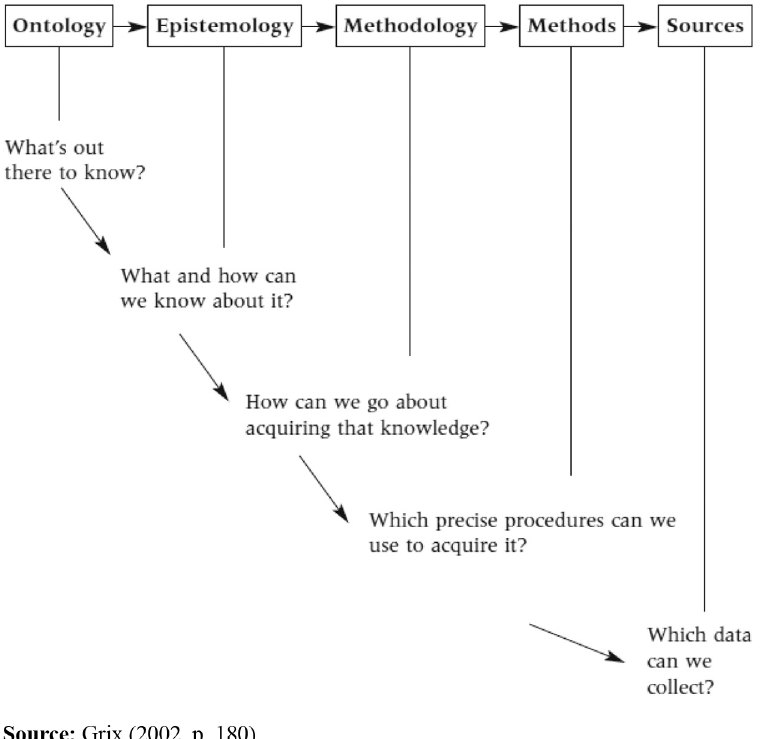
Figure 1. The interrelationship between the building blocks of